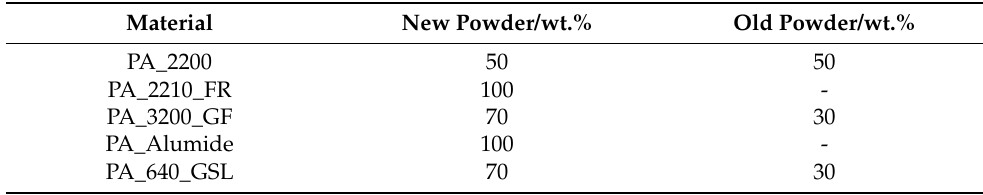
Table 1. Powder refreshing